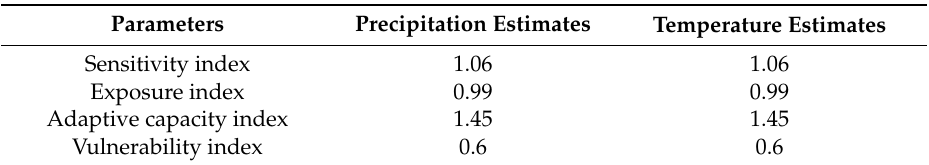
Table 2. National-scale estimates of the vulnerability of maize yield to droughts in Uganda based on precipitation and temperature